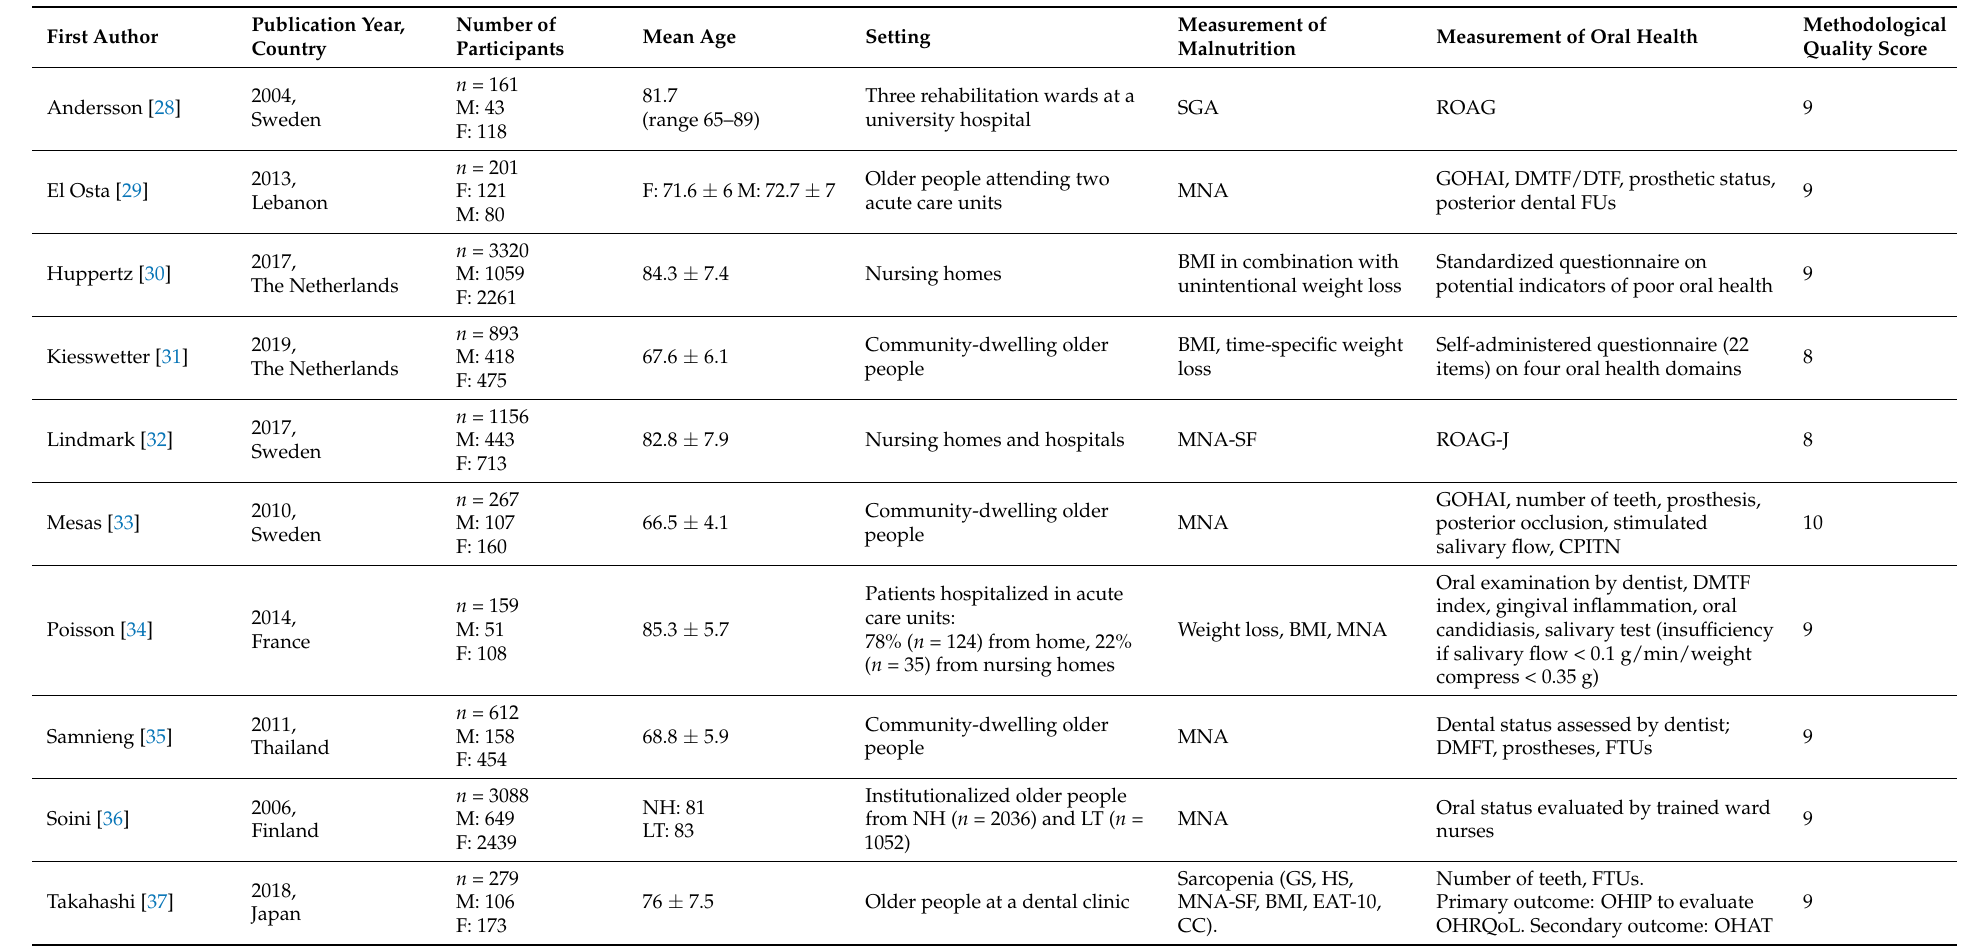
Table 1. Main study